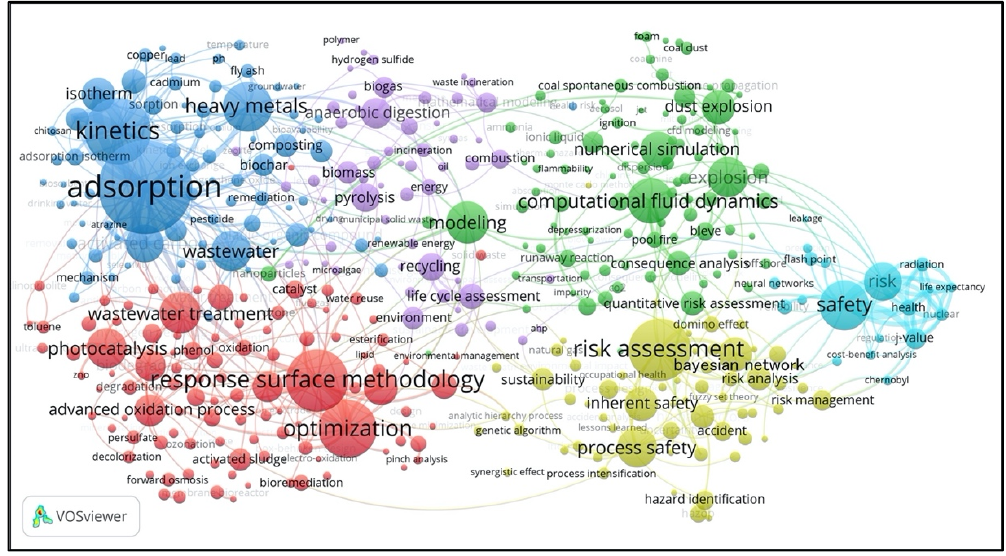
Figure 8. Keyword co-occurrence cluster of PSEP papers.